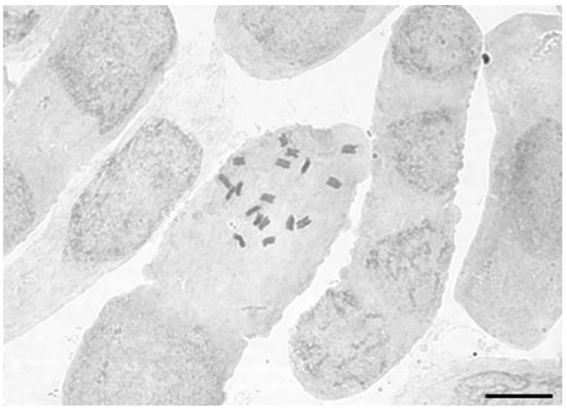
Figure 3. Root tip squash showing 2n = 18 chromosomes for an individual of Sclerolaena napiformis grown from seed collected at Cope Cope, Victoria (site SN24), viewed under oil immersion ( × 1000). Scale bar = 10 µ m.